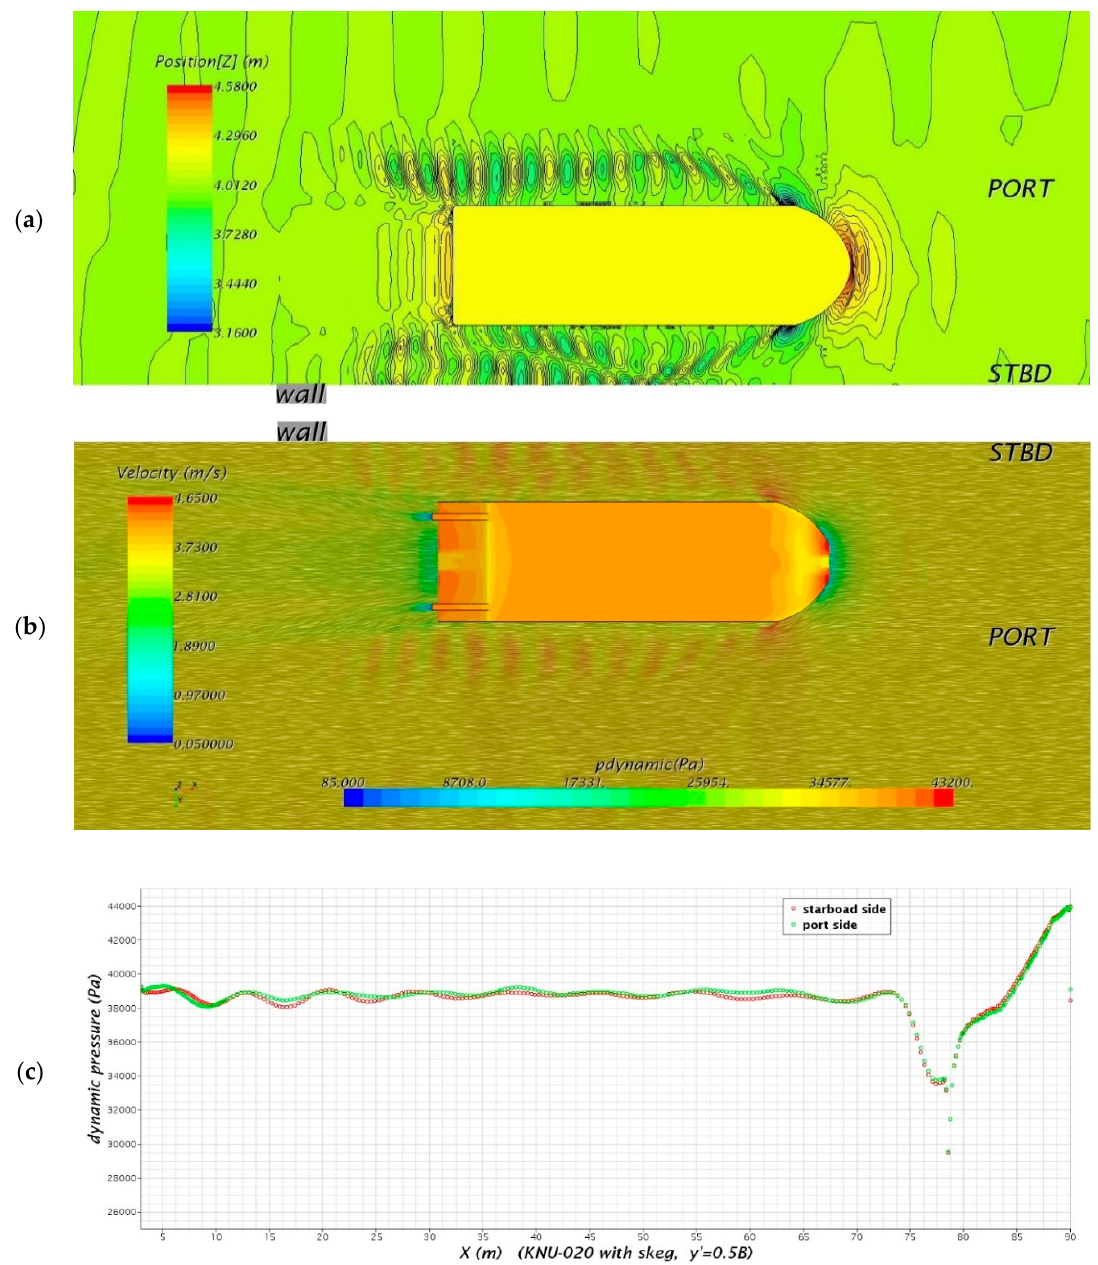
Figure 7. Simulation results for KNU-020 at y ′ = 0.5 B : ( a ) wave pattern; ( b ) velocity field with line integral convolution and hydrodynamic pressure distribution on the bottom; and ( c ) hydrodynamic pressure on the starboard and port side.